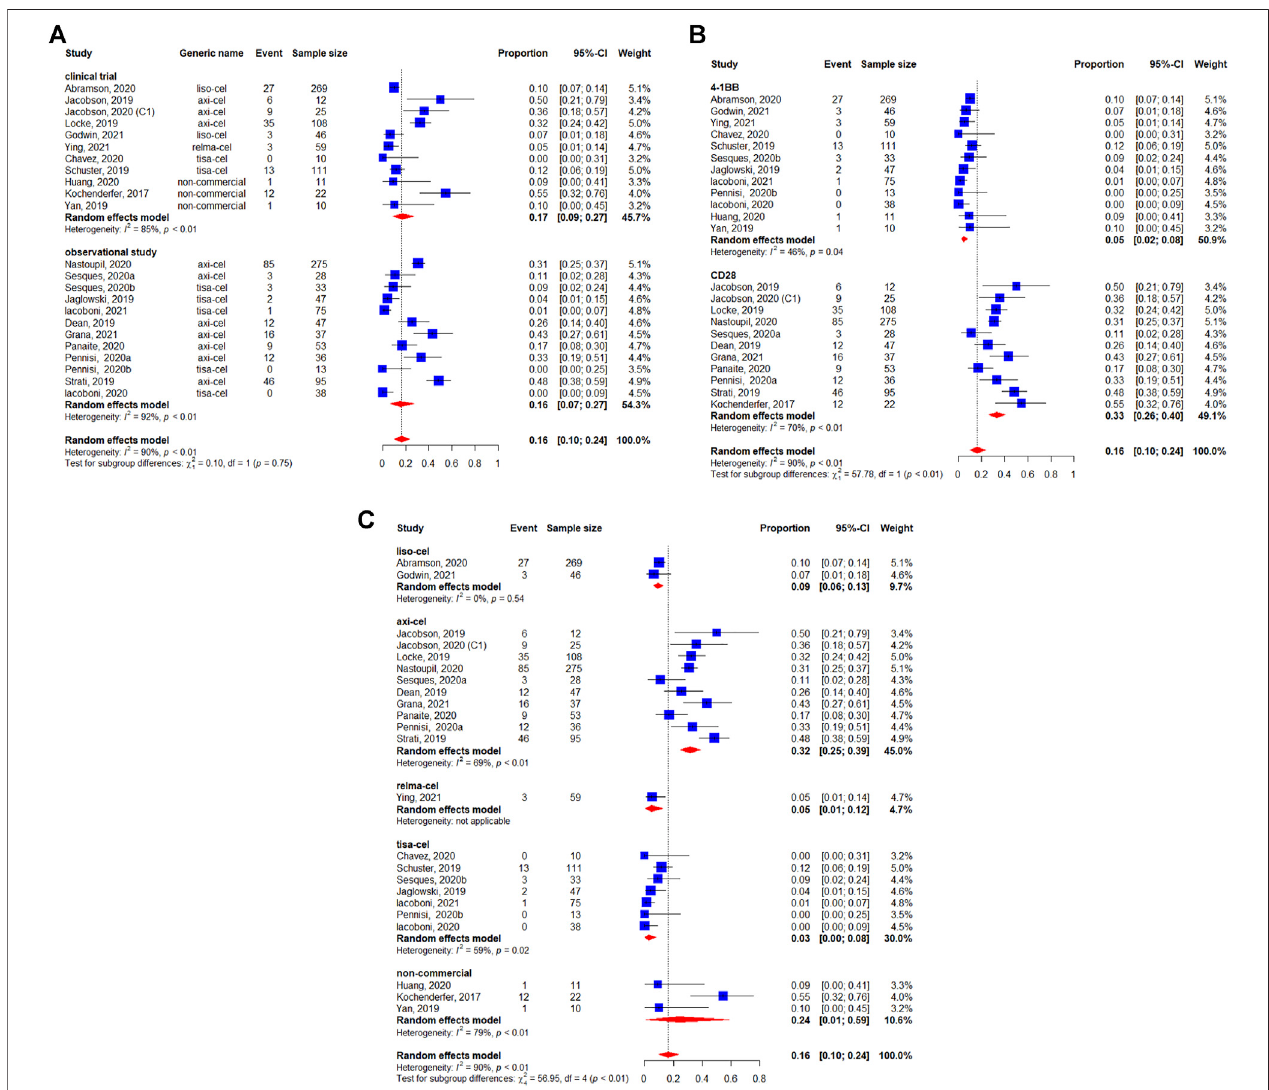
FIGURE 9 | Severe (grade ≥ 3) neurotoxicity of patients with diffuse large B-cell lymphoma (DLBCL) treated with chimeric antigen receptor T cells (CAR-Ts) according to (A) study design, (B) the costimulatory domain, and (C) type of chimeric antigen receptor T cells (CAR-T).